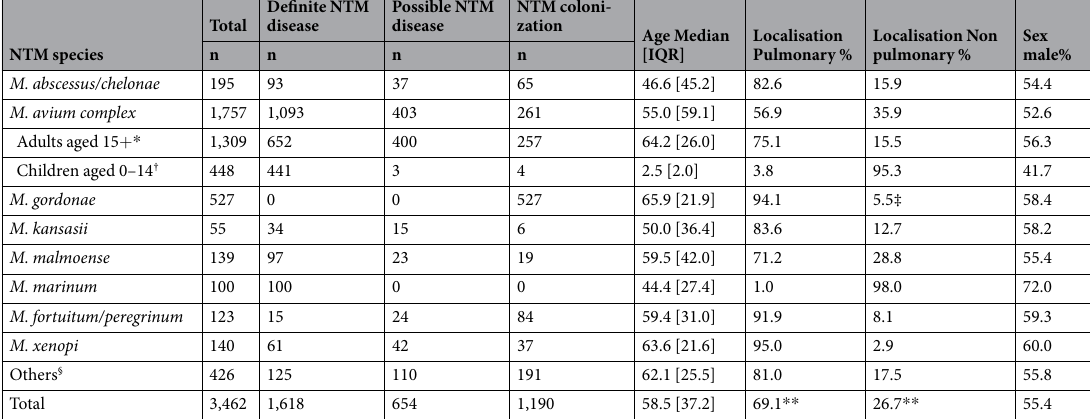
Table 1. NTM frequency according to disease category, age, sample localization, and sex. * Among adults with MAC, 9.4% (123) were from a multifocal origin (total 1,309). † Among children 0.9% (4) were from a multifocal origin (a total of 448/561 samples were MAC). ‡ Of these, 76% (22/29) of specimens were from urine or fecal samples. § Others including uncommon mycobacteria and mycobacteria not identified (a complete list is available in Table 4). ** 4.2% of samples were from a multifocal